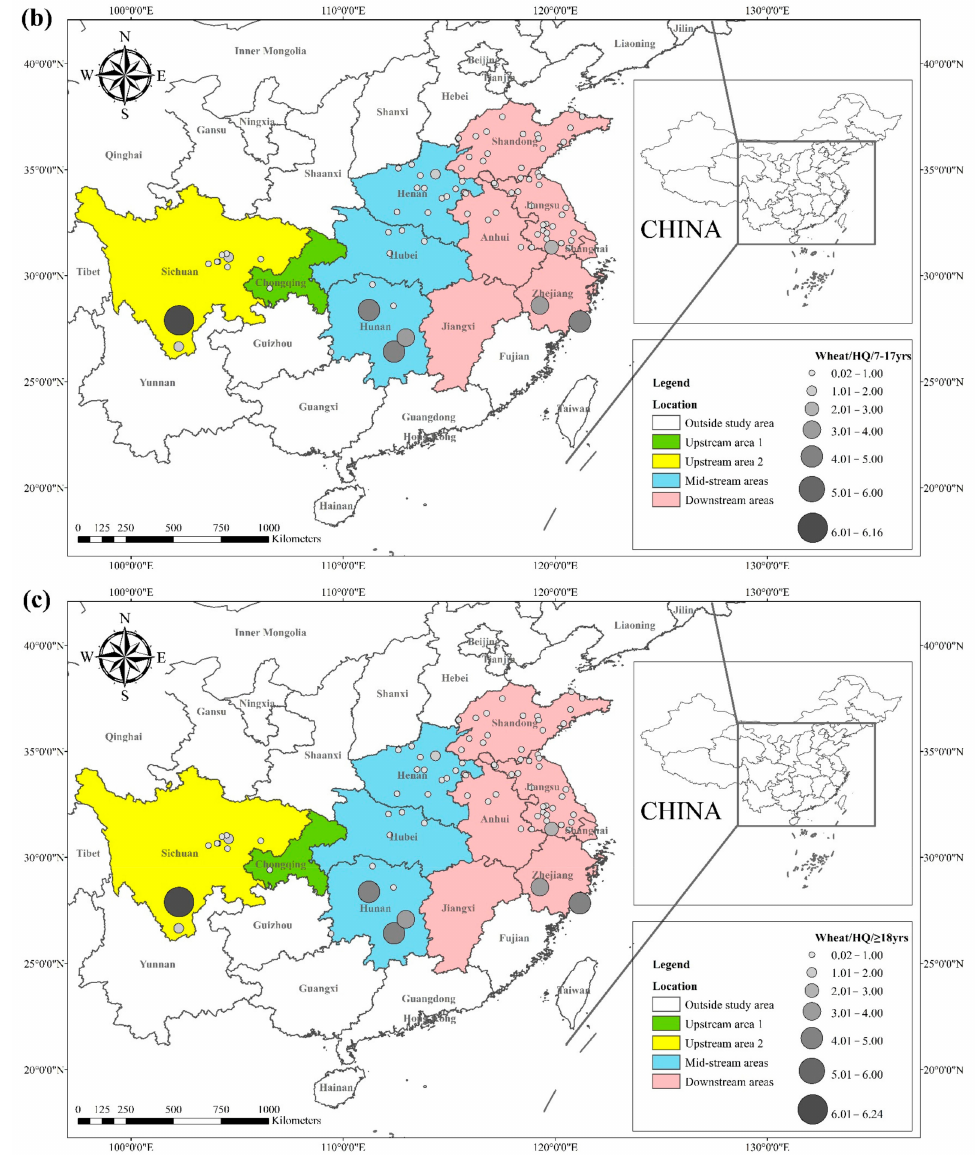
Figure 4. ( a ) HQ /2–6 yrs., ( b ) HQ /7–17 yrs., and ( c ) HQ / ≥ 18 yrs. of Cd in wheat based on data collected from previous